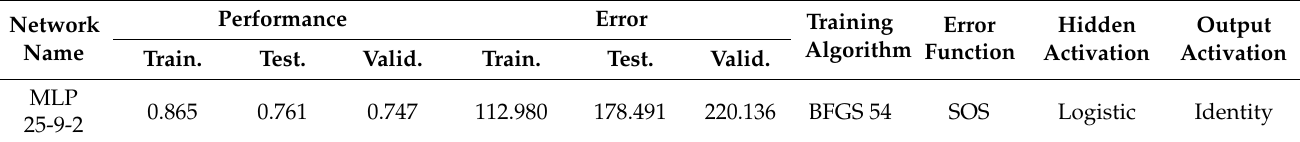
Table 2. ANN summary (performance and errors), for training, testing, and validation cycles.